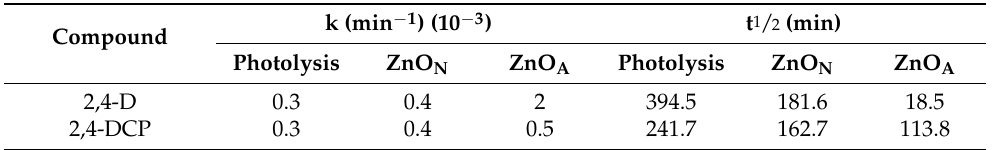
Table 4. Rate constant for the pseudo-first order kinetic equation and half-life time for the 2,4-D and 2,4-DCP degradation in presence of ZnO